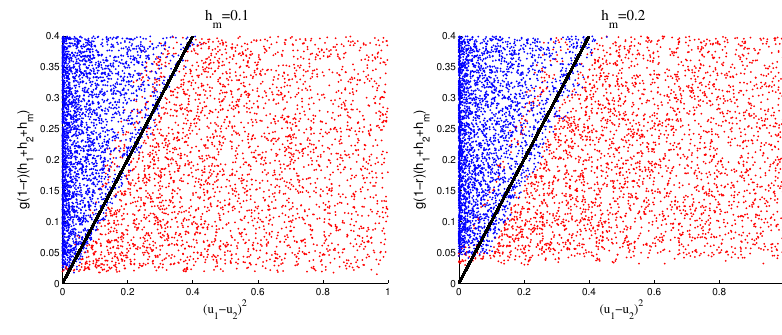
Figure 14. The same as in Fig. 13 but with h m = 0 . 1 (left) and h m = 0 . 2